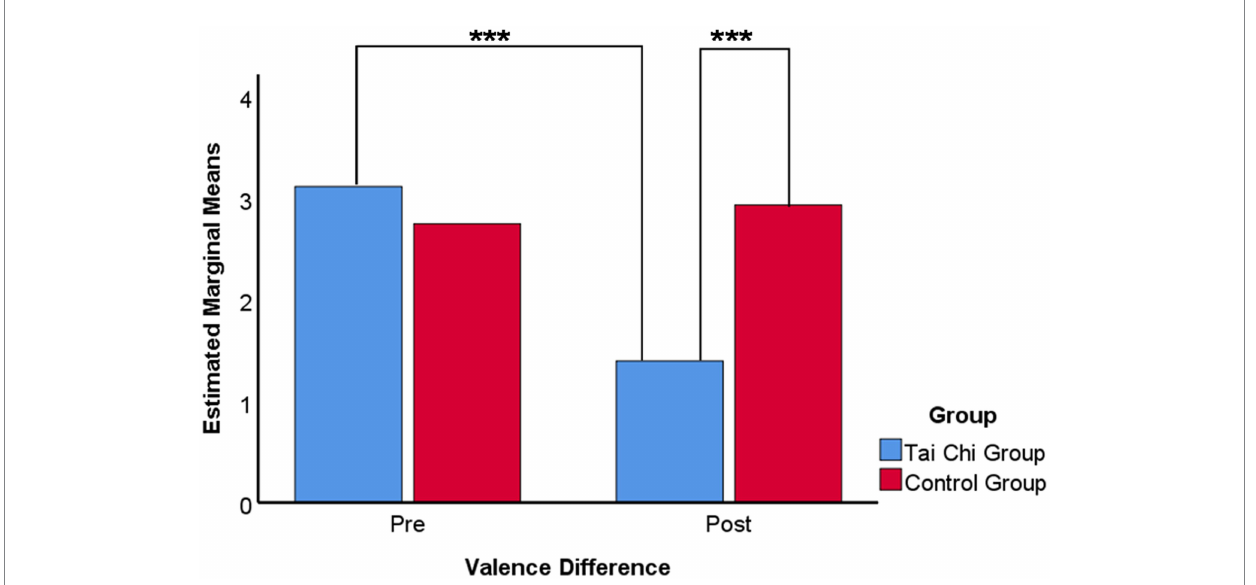
FIGURE 6 Multiple means comparison of valence difference on emotion regulation ability. Bonferroni adjustment for multiple comparisons. *** p -value <0.001, ** p -value <0.01, * p -value <0.05.